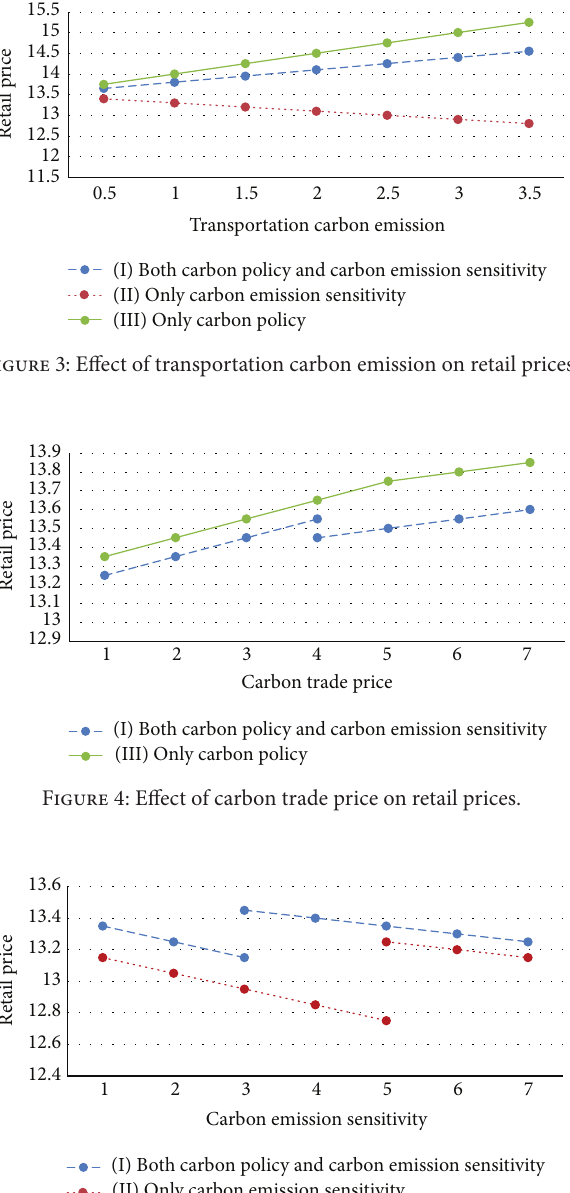
Figure 9: Effect of carbon emission sensitivity on order quantities.